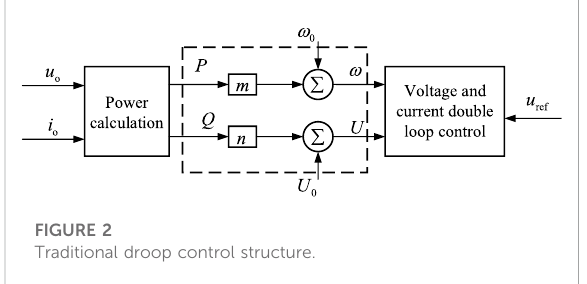
FIGURE 2 Traditional droop control